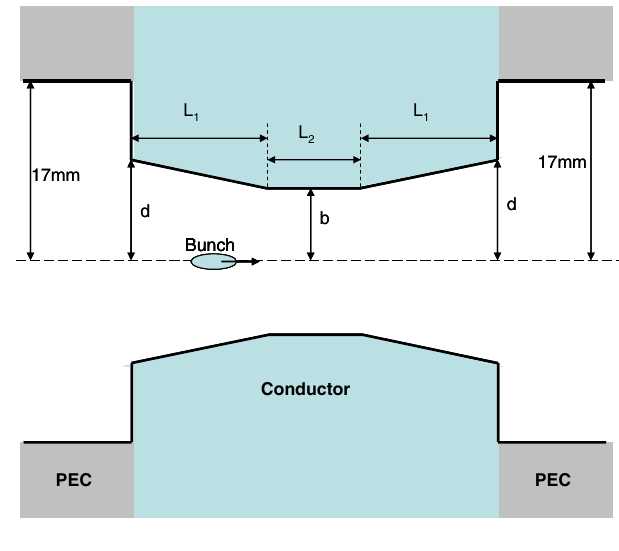
FIG. 13. Cross section of the tapered collimator.